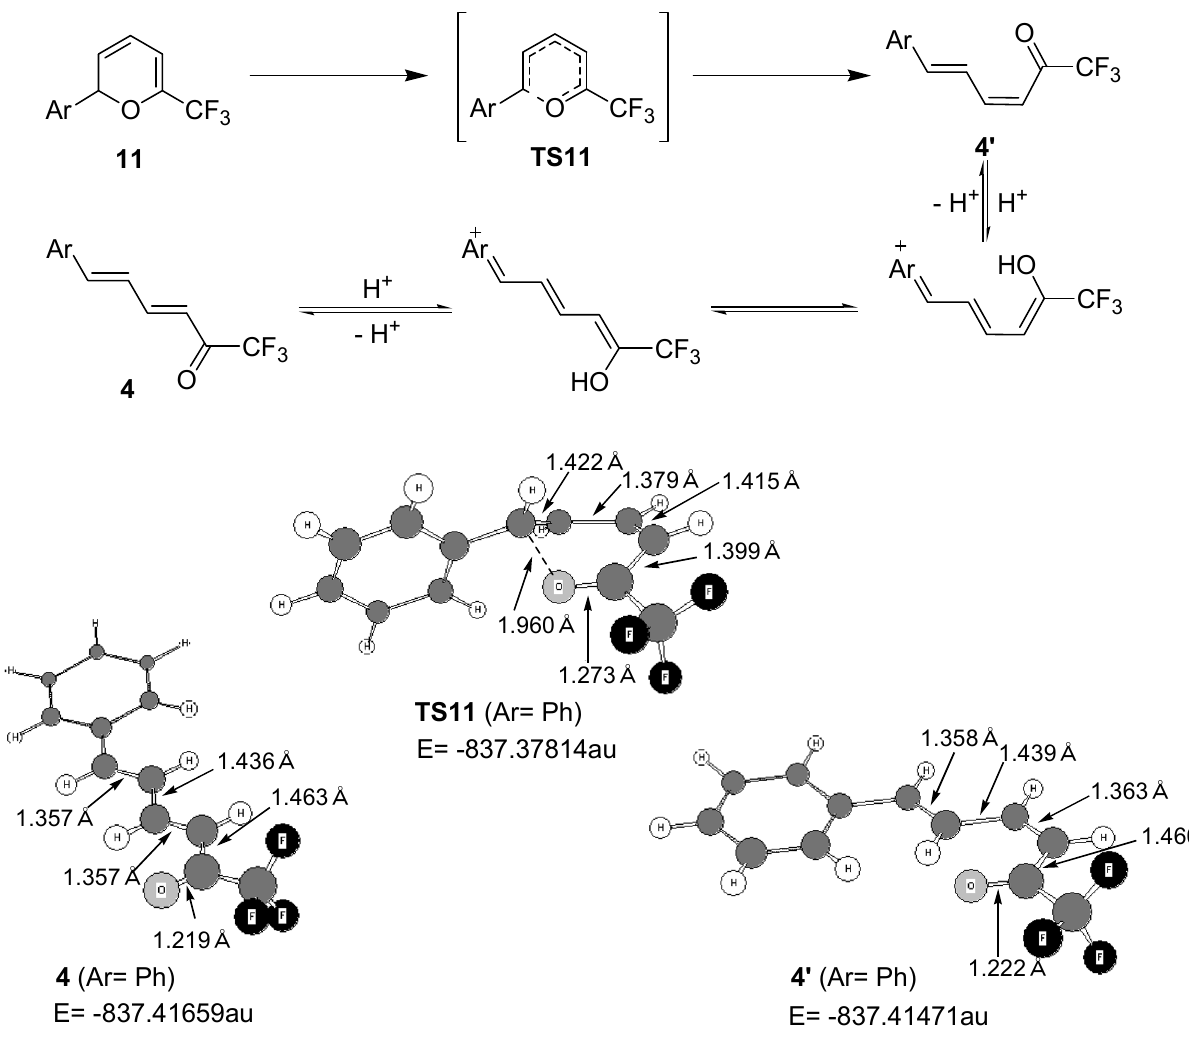
Figure 3. Ring-opening process from 2 H -pyrans ( 11 ) to ( E , E )-dienes ( 4